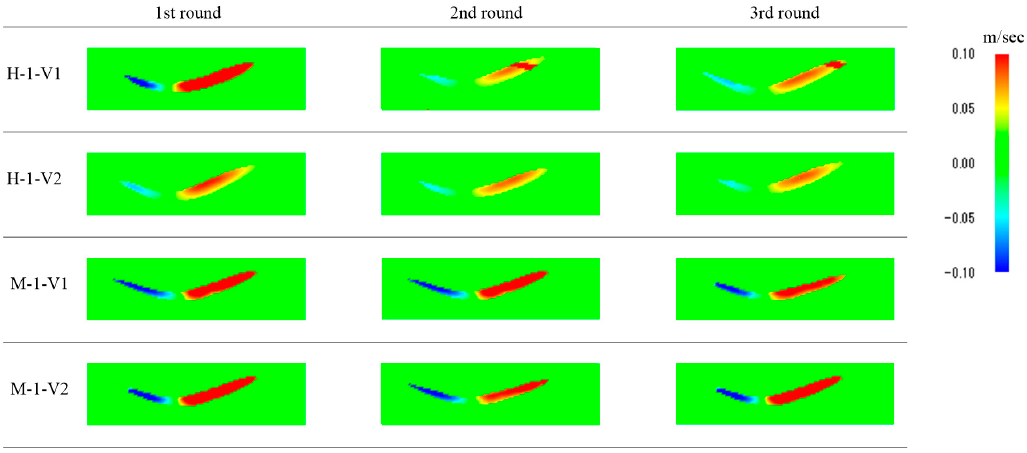
Figure 9. Average of the vertical flow velocity distributions: 1 is v n , and 2 is v n + 1 .